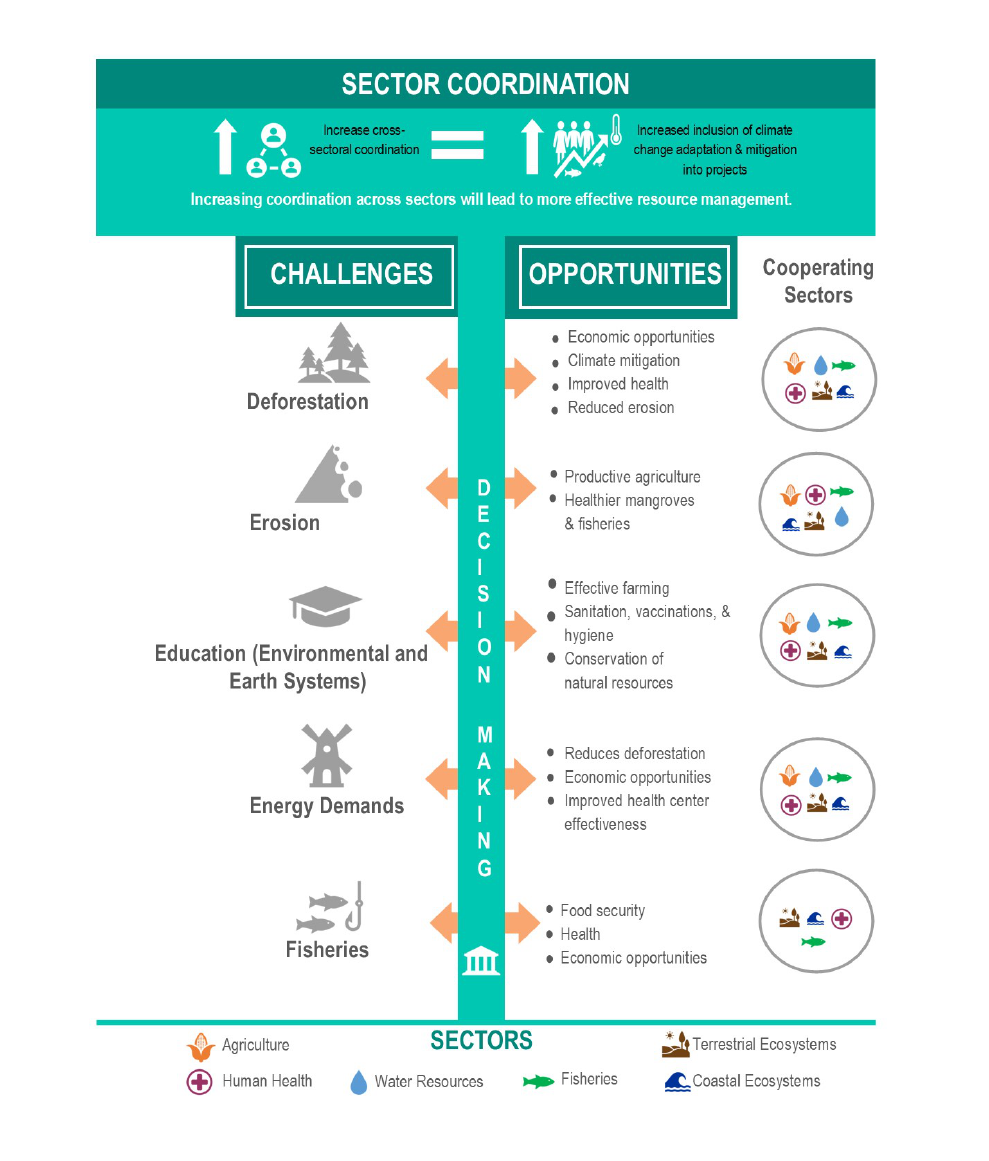
Fig. 2 . Interlinkages among sectors in adapting to climate change. Addressing non-climate stressors (Challenges) will make the system more resilient to climate and allow for increased socioeconomic and ecological sustainability (Opportunities). Efforts across multiple sectors are required to address the challenges that face